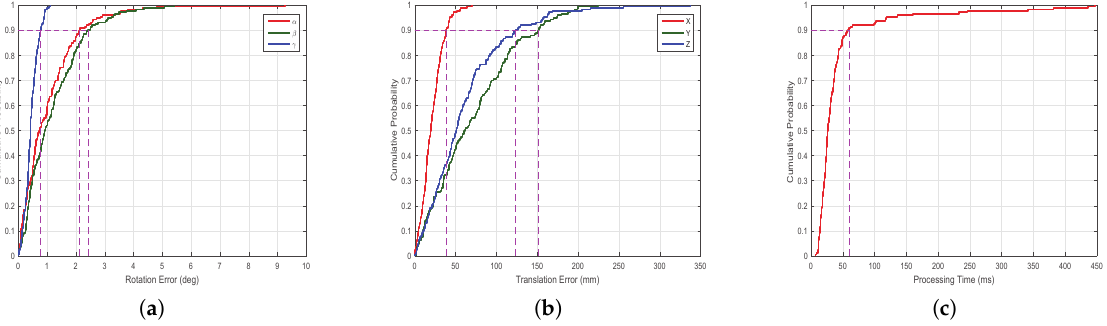
Figure 9. Performance of congruent tetrahedron align algorithm. ( a ) CDF of rotation error; ( b ) CDF of translation error; ( c ) CDF of processing